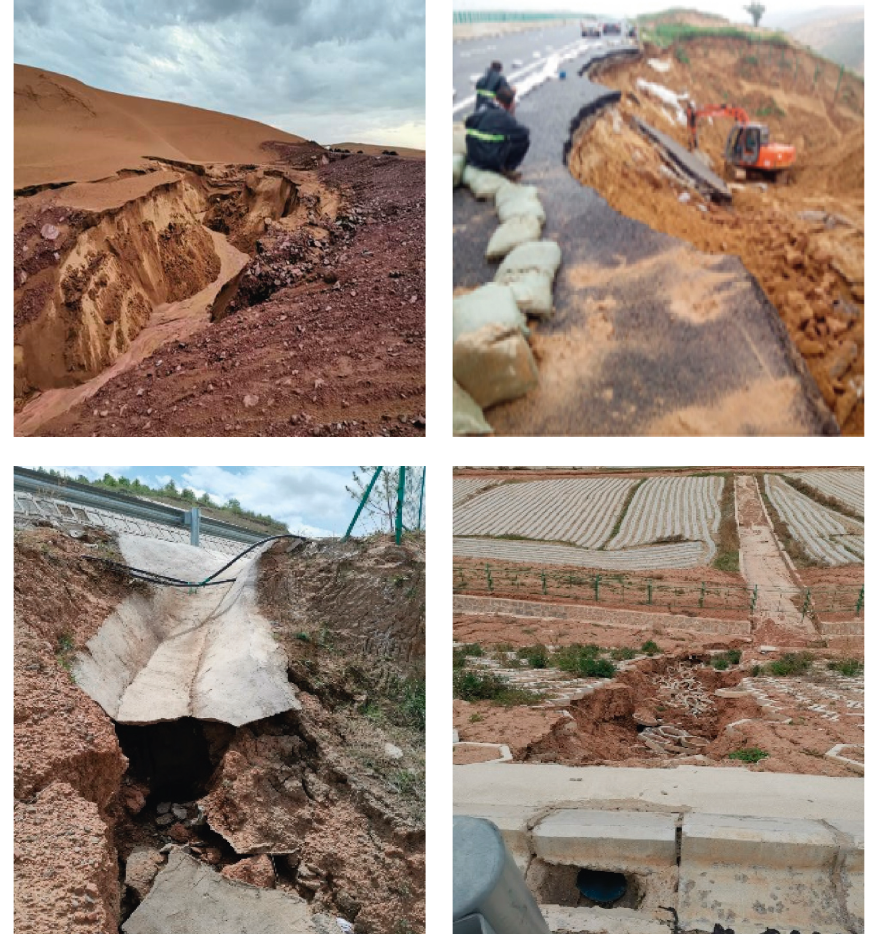
Figure 3: Picture of drainage ditch water damage